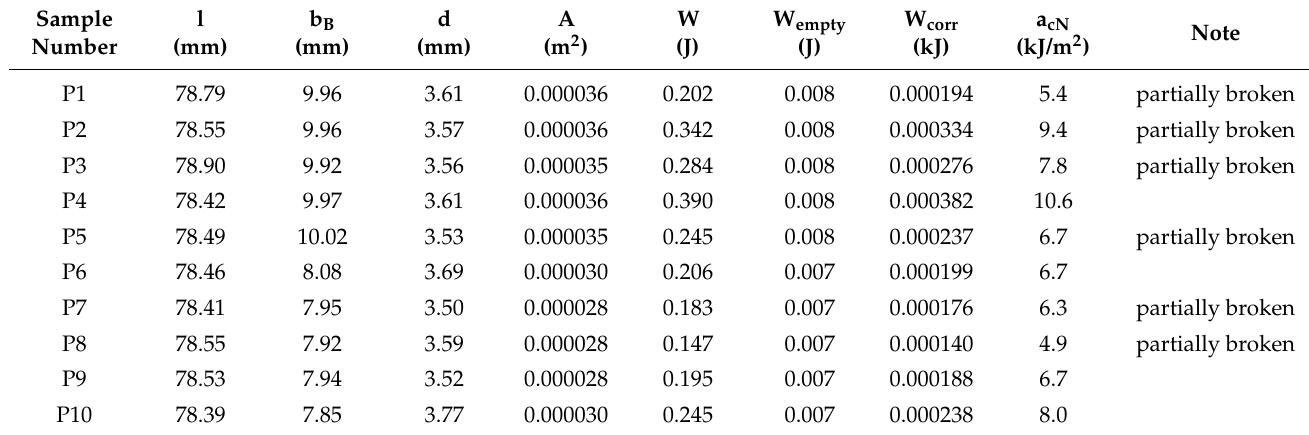
Table A22. Results of the notched impact tests and unnotched impact tests of PO_B.